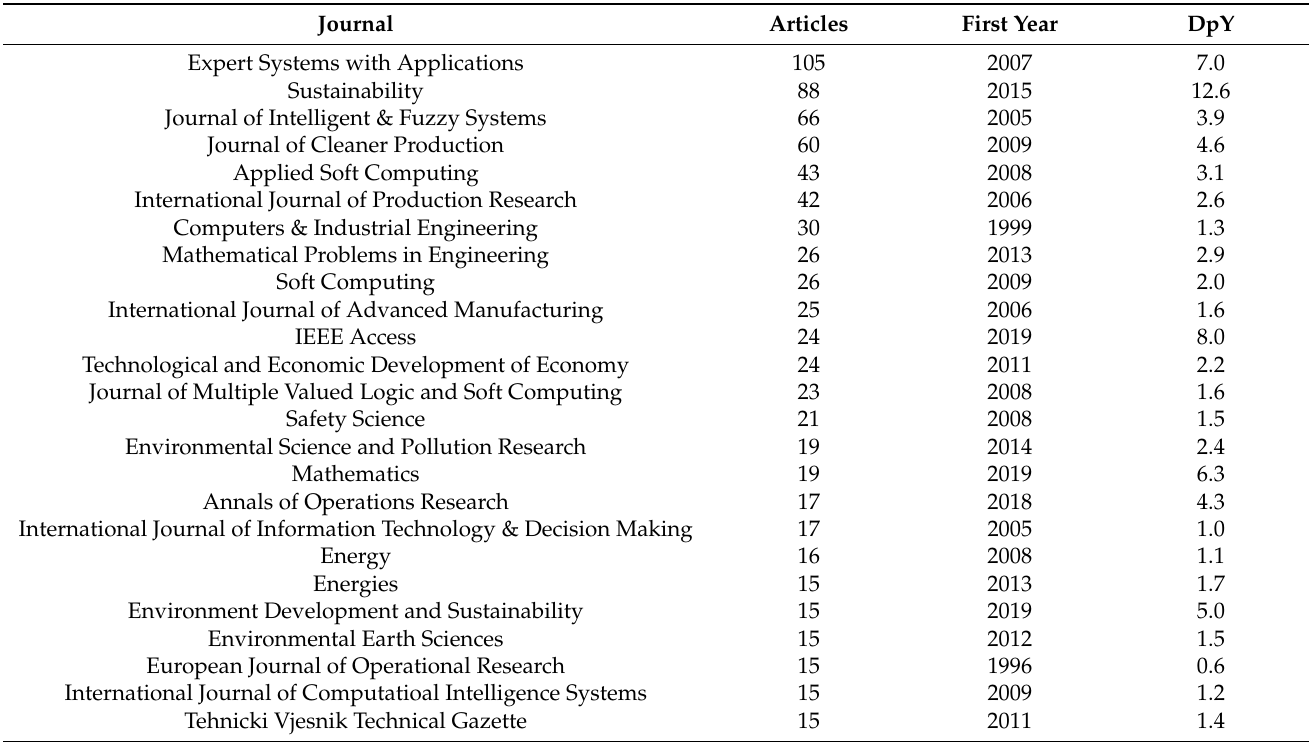
Table 3. Top 25 Journals by